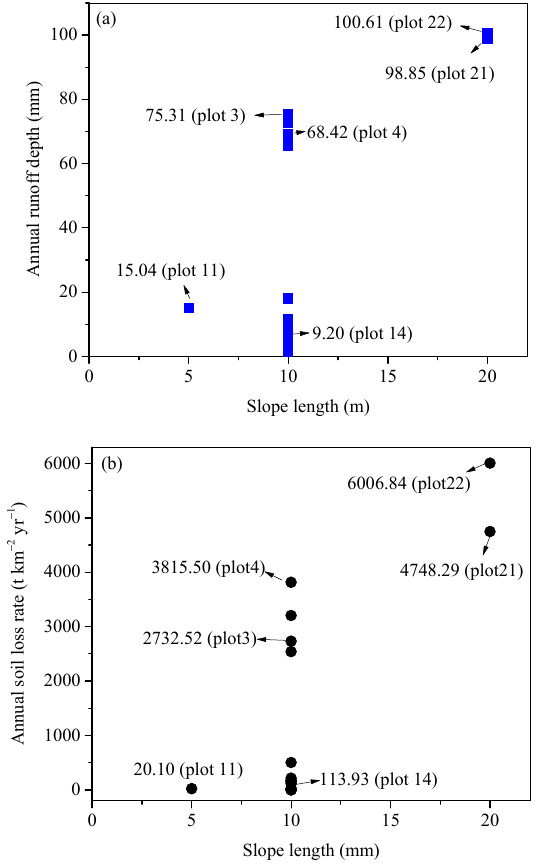
Figure 6. Annual runoff depth ( a ) and soil loss rate ( b ) for the 22 runoff plots in 2014–2020 with slope length.